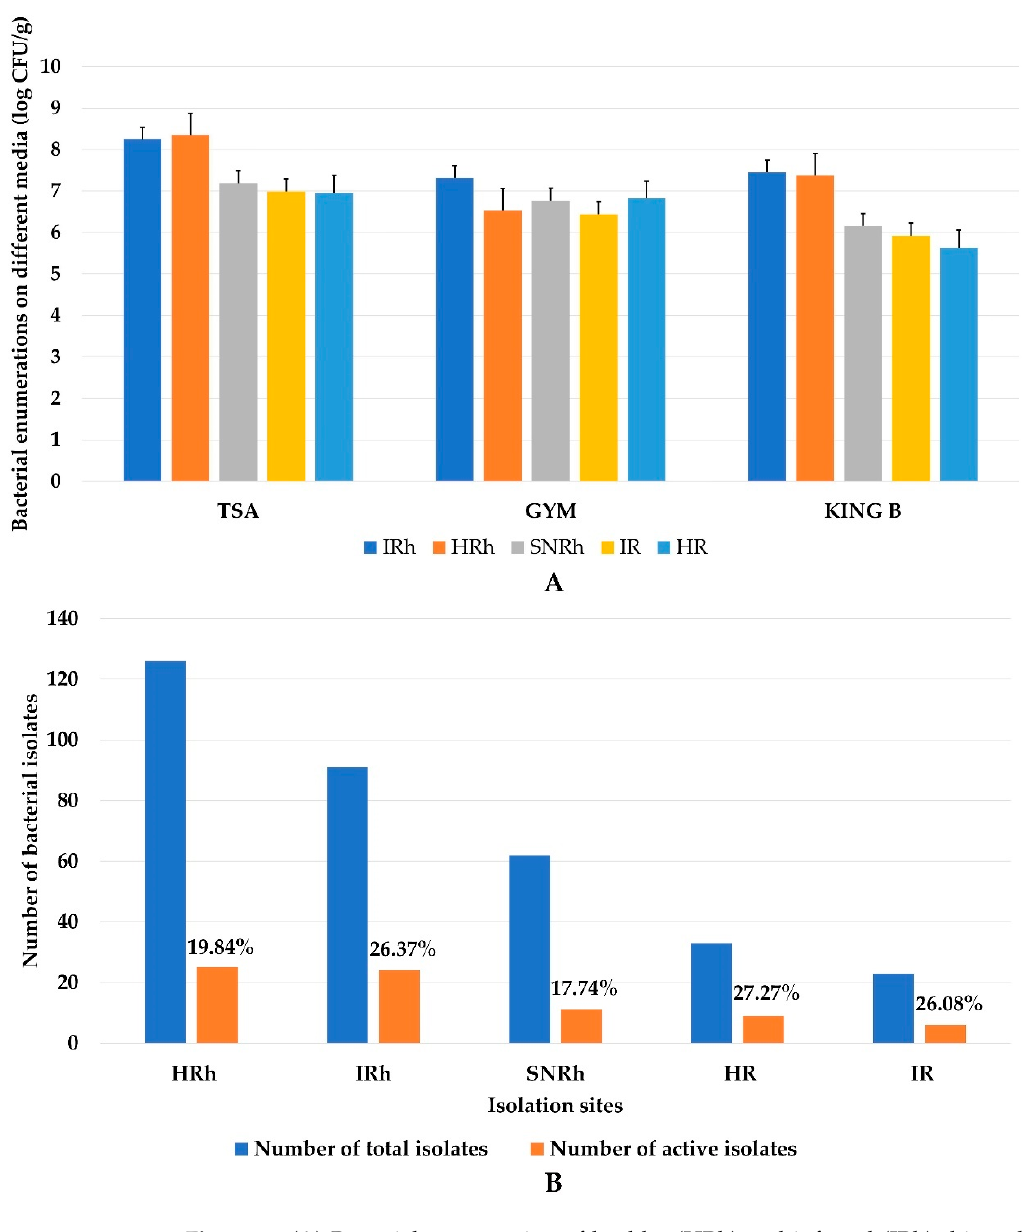
Figure 2. ( A ) Bacterial enumeration of healthy (HRh) and infected (IRh) rhizospheric soil, non-rhi- zospheric (SNRh) soil, and endophytes of healthy (HR) and infected (IR) roots in different culture media (TSA, GYM, and King B); ( B ) The percentage of bacteria antagonistic to FOA by isolation site (HRh, IRh, SNRh, HR, and IR).